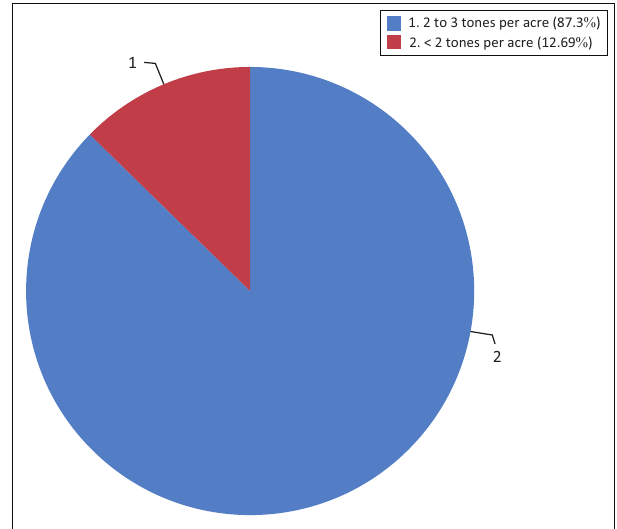
FIGURE 5: Farmers perception (%) on the amount of maize (ton/ha) produced before and after fall armyworm